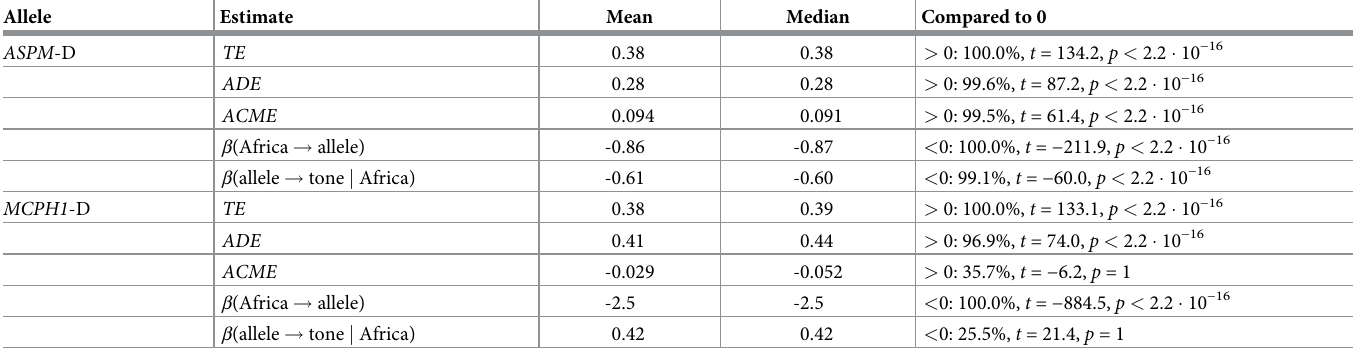
Table 9. Summaries of the mediation analysis for 1,000 restricted samples for tone1 . For each “derived” allele the table shows the three types of effects (total, direct and mediated) and the two (partial) regression coefficients. For each, it gives the mean, median and the results of the relevant comparison with 0.0 (smaller or bigger) in terms of the percent of the estimates smaller (or bigger) than 0.0 and the one-sided t -test ( df = 999); the direction of the comparison is based on a priori expectancies: positive effects but negative β s.